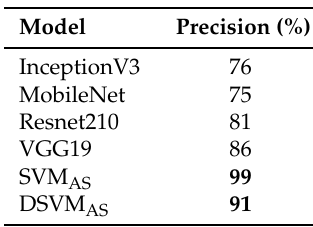
Table 10. Maximum precision for the deep learning models after 1000 training cycles. The bold values simply indicate the higher precision.